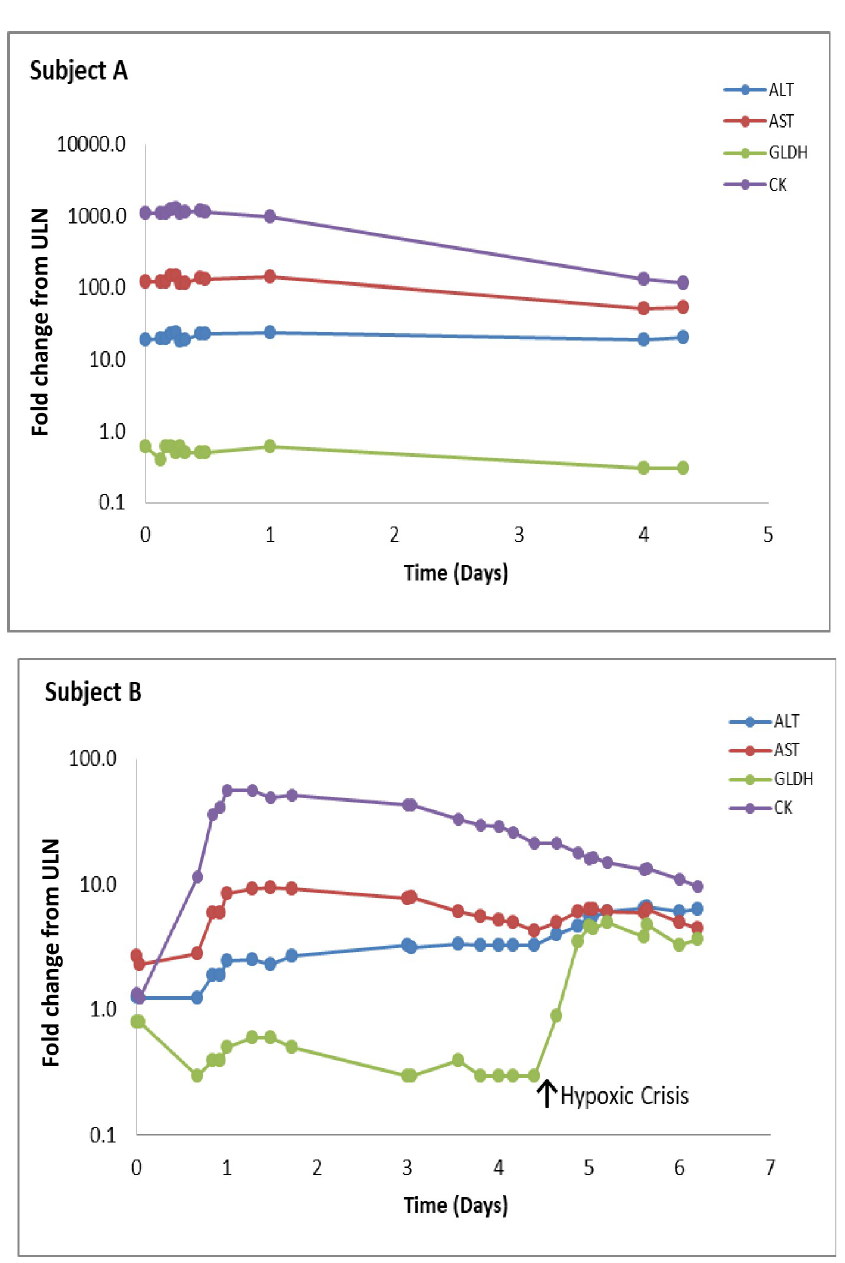
Fig 3. GLDH detects the onset of liver injury in a subject with rhabdomyolysis. Comparison of ALT, AST, GLDH and CK levels from consecutive blood draws for 2 subjects with rhabdomyolysis. The values represent fold increase from control using the upper limit of normal (ULN) in healthy subjects as the control